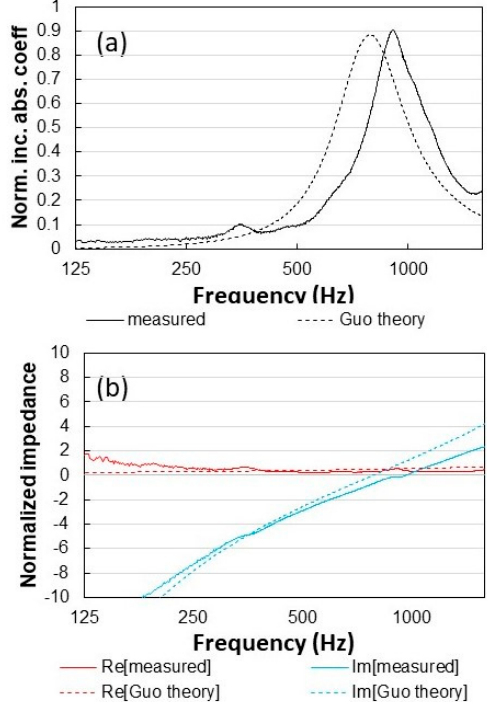
Figure 9. Comparison of the measured (solid line) and calculated (dashed line) values of the normal absorption coefficient ( a ) and specific impedance ( b ) of Specimen #3, with an air-back cavity of 25 mm depth.